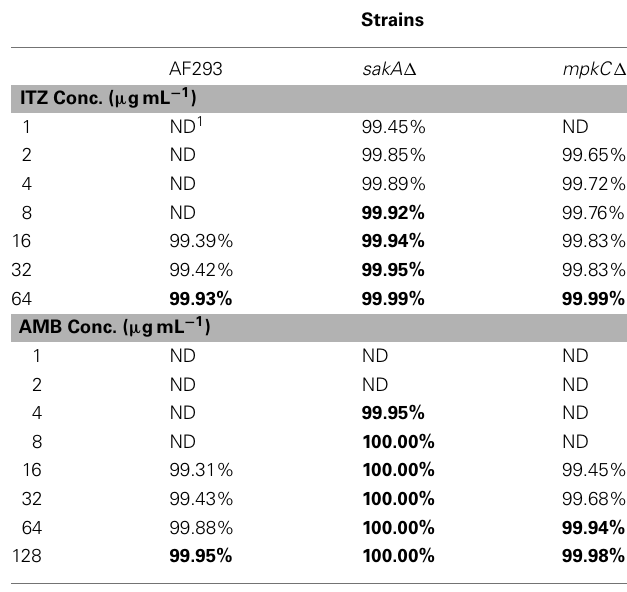
Table 1 | Levels of fungicidality of itraconazole (ITZ) or amphotericin B (AMB) at various concentrations against Aspergillus fumigatus strains (AF293, sakA Δ , mpkC Δ